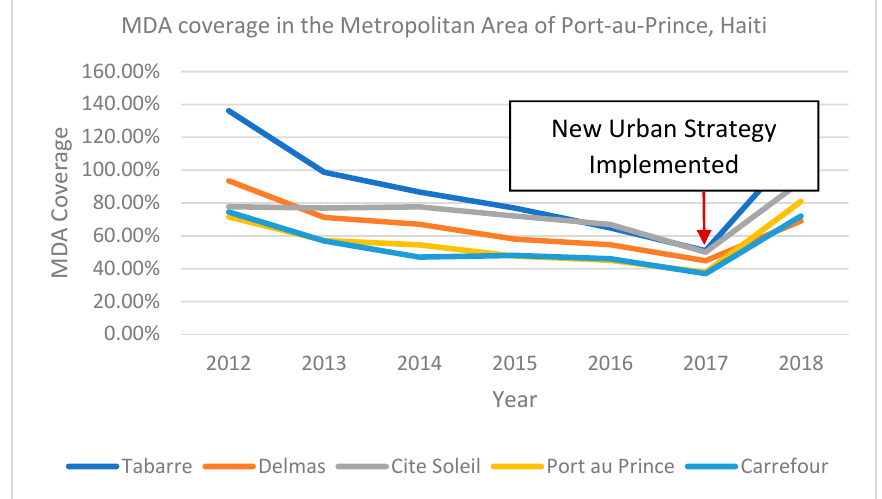
Figure 1 . MDA coverage in the metropolitan area of Port-au-Prince, Haiti (2012–2018). Figure 1. MDA coverage in the metropolitan area of Port-au-Prince, Haiti